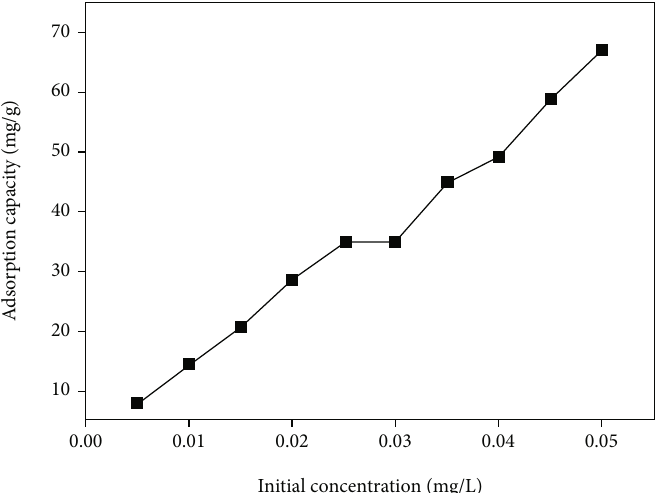
Figure 8: The e ff ect of initial concentration of MG (condition: the dosage of adsorbent used = 0 : 90g · L − 1 , contacttime = 150 min , temperature = 303 : 15 K , and shaking speed = 200rpm